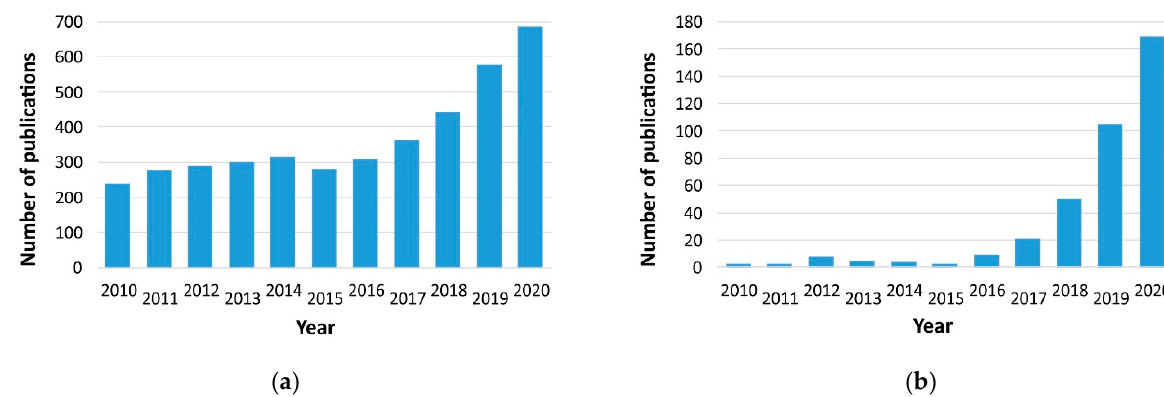
Figure 1. Number of publications indexed in the Web of Science database in research of steels and metal alloys, which describe the application of ( a ) artificial neural networks and ( b ) deep neural networks.